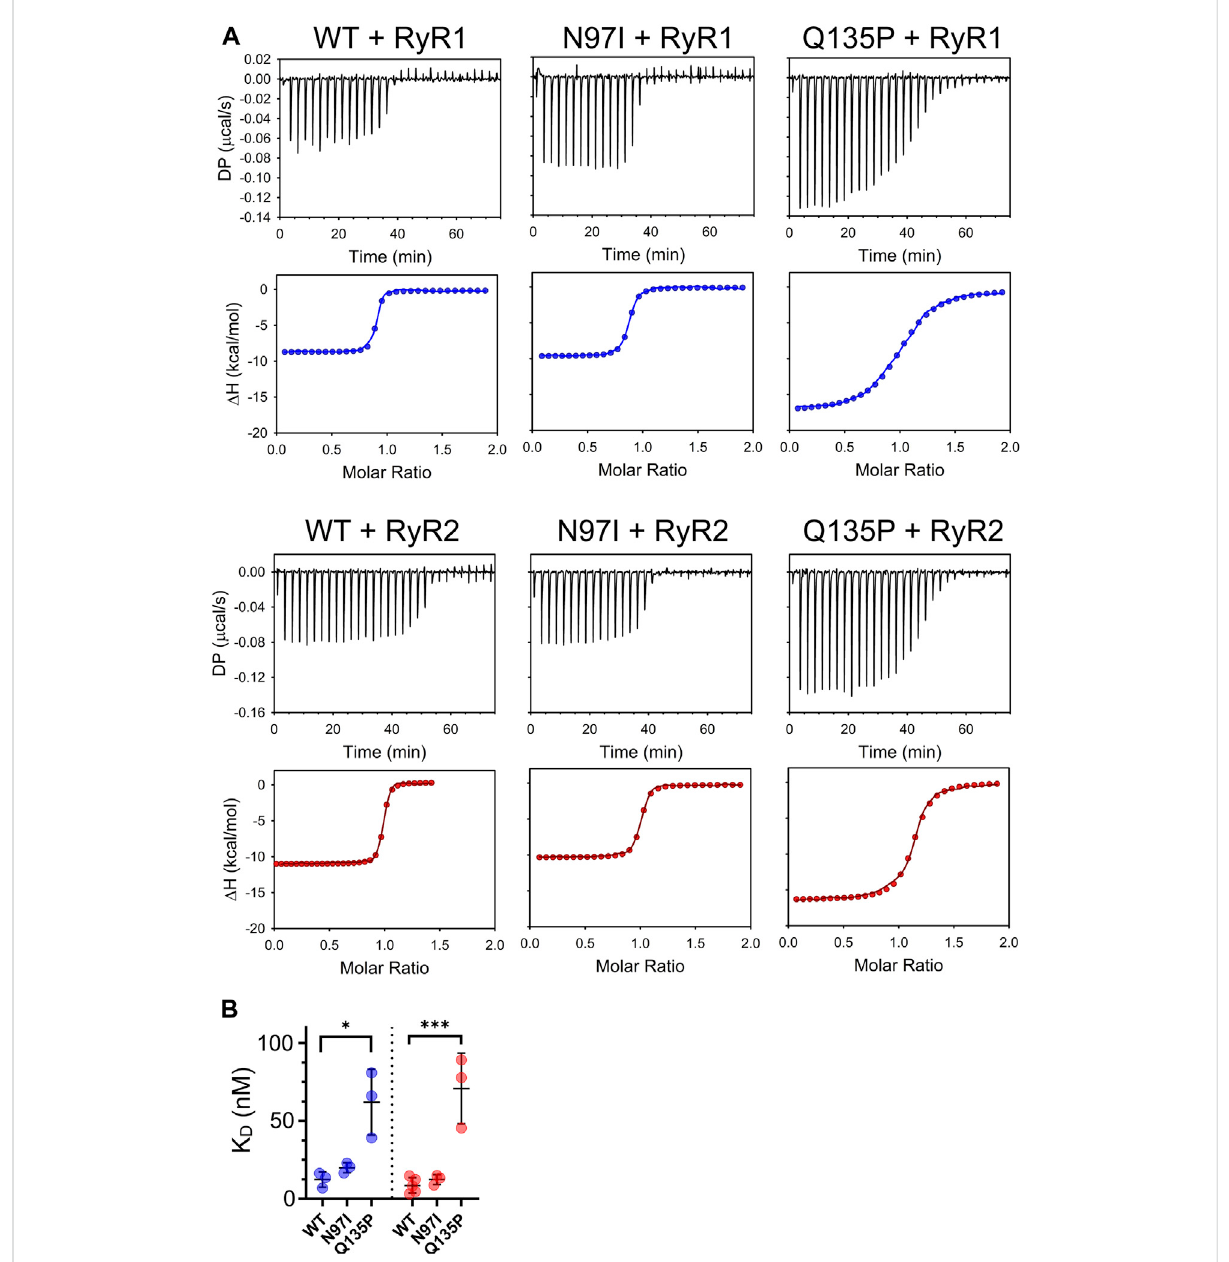
FIGURE 5 ThermodynamicsofCaM-RyR1/2peptide interaction assessed byisothermal titration calorimetry. (A) ExamplesofITC titration curvesobtained for each CaM variant upon interaction with RyR1 or RyR2 peptides. Measurements were performed at 25 ° C using 20 mM Tris pH 7.5, 150 mM KCl, 5 mM Ca 2+ as working buffer and setting stirring at 750 rpm. Each titration consisted in thirty 1-µL injections of 125 µM RyR1 or RyR2 (into the titrant syringe) with 10 µM CaM variants. (B) Scatter plot of replicates summarizing the K D values calculated from the fi tting using a one-site binding model (see Materials and Methods). Stars represent the p -values: * p ≤ 0.05, *** p ≤ 0.001. Data for WT CaM titration with RyR2 are from (Dal Cortivo et al.,